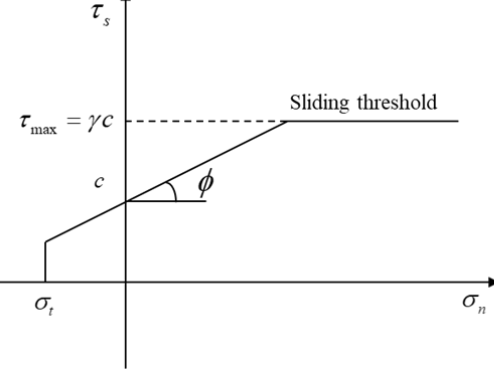
Figure 2. Strength curve of parallel bond model.